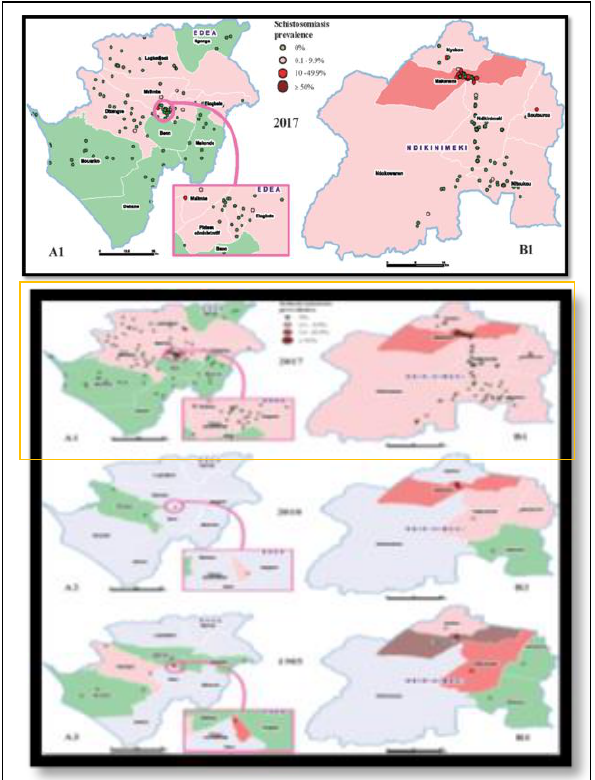
Figure 1. Comparison of precision and conventional maps in the health districts of (Districts A) and (Districts B), Cameroon. (Tchuem Tchuenté et al.,